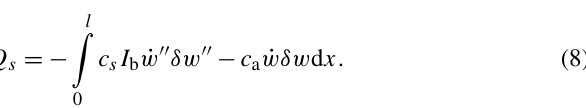
Figure 3. Simplified model for